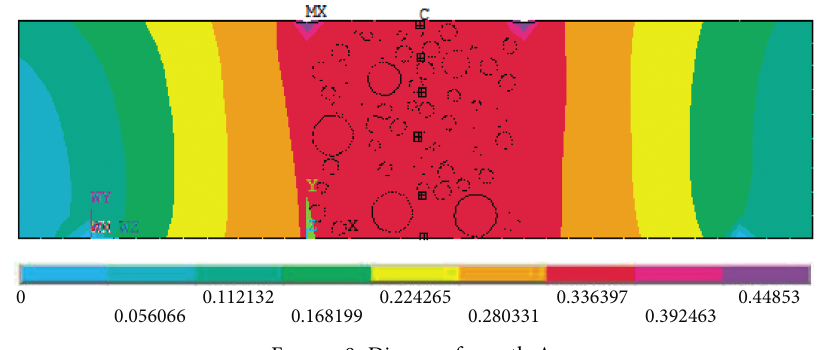
Figure 8: Diagram for path A.